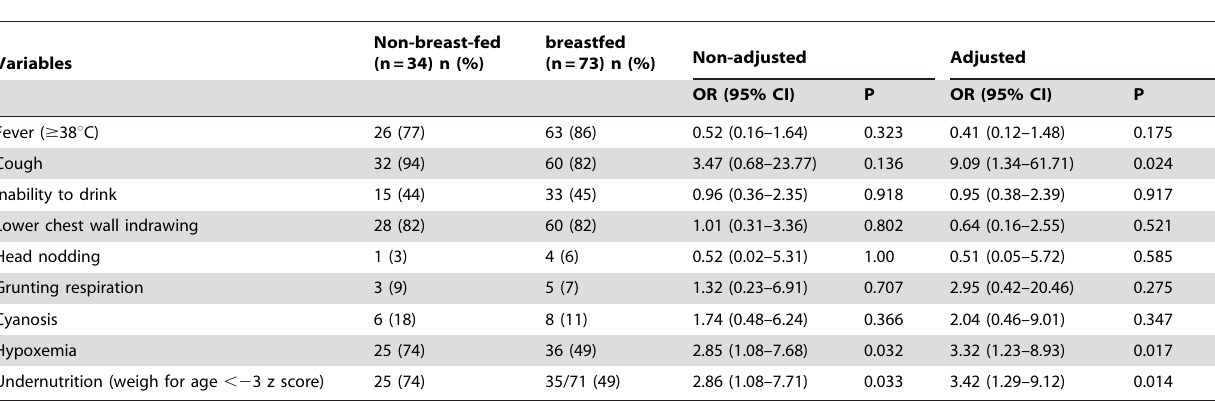
Figure represents n (%), unless specified otherwise; OR=Odds ratio; CI=Confidence interval. doi:10.1371/journal.pone.0025817.t002 PLoS ONE |